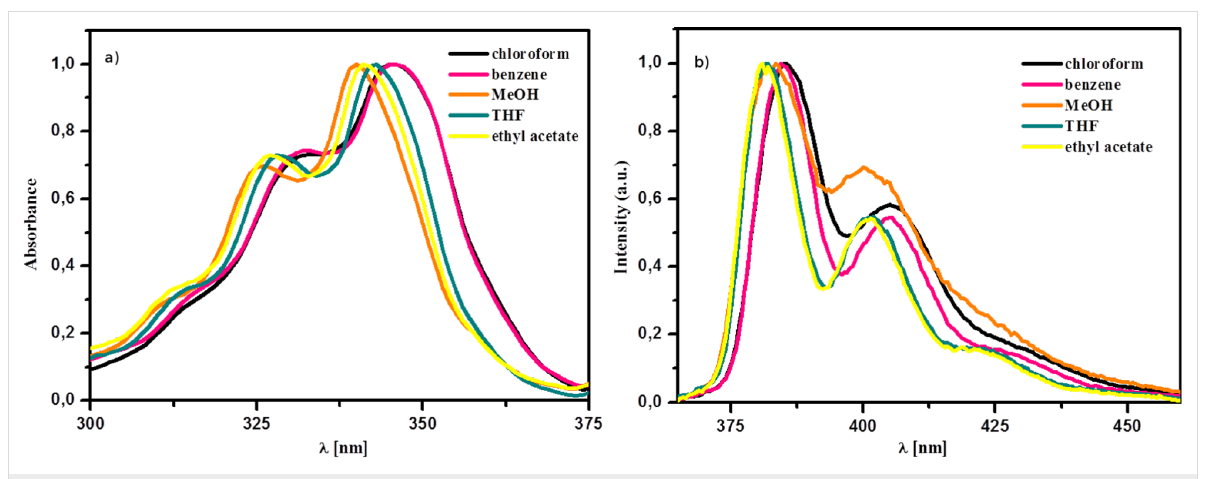
Figure 2: Normalized electronic absorption (a) and emission (b) spectra of 3a in various solvents.